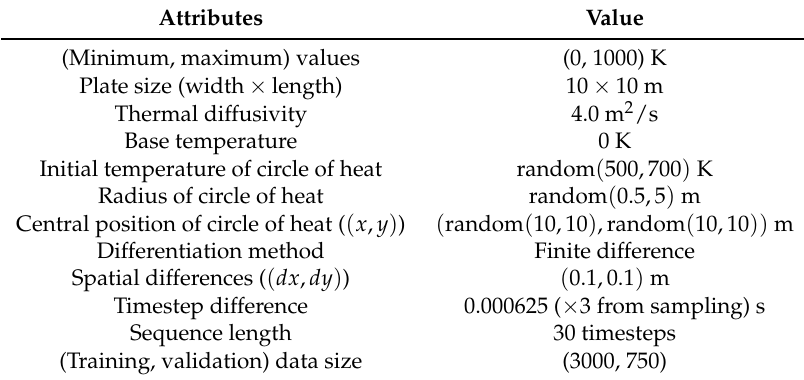
Table 1. Generation details of the 2D heat equation data. The random ( min , max ) here means that